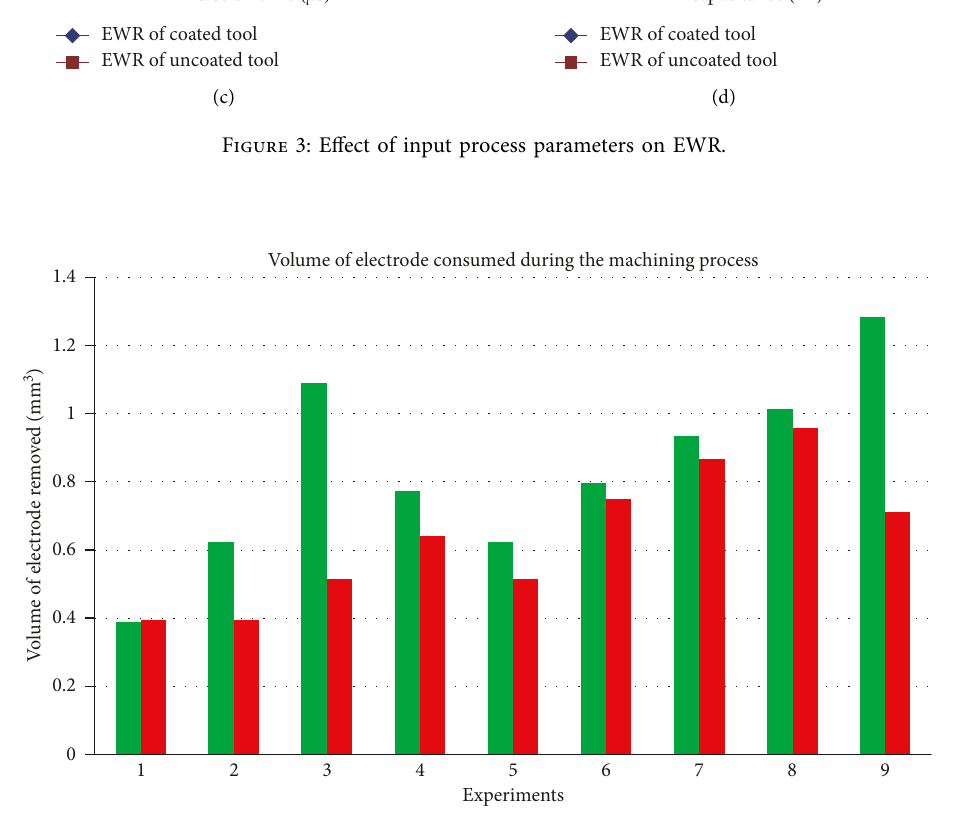
Figure 4: The volume of electrodes removed by coated and uncoated electrodes.